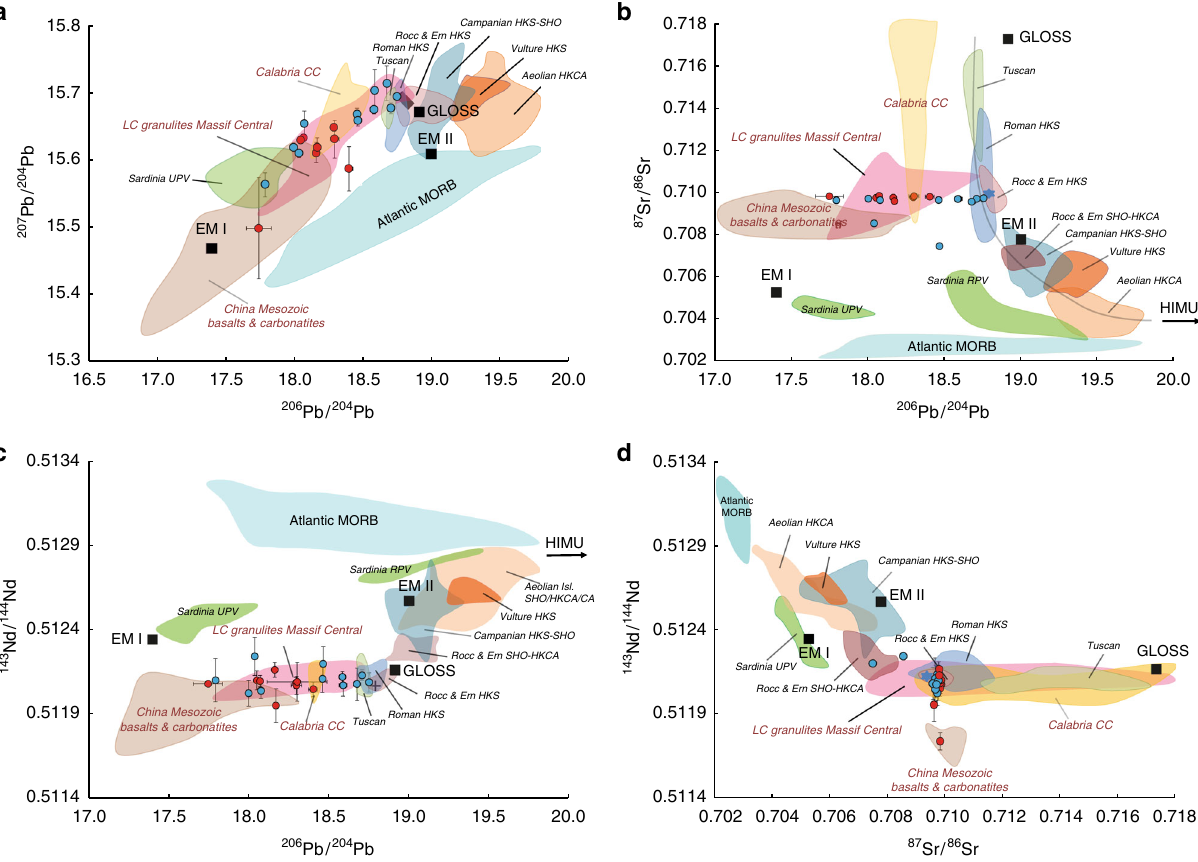
Fig. 3 Sr-Nd-Pb isotope data for the analysed melt inclusions. a 207 Pb/ 204 Pb versus 206 Pb/ 204 Pb; b 87 Sr/ 86 Sr versus 206 Pb/ 204 Pb; c 143 Nd/ 144 Nd versus 206 Pb/ 204 Pb; d 143 Nd/ 144 Nd versus 87 Sr/ 86 Sr. Error bars represent 2SE. Data are compared to fi elds for Italian lavas 76,77 , Calabrian Continental Crust 78 , Atlantic MORB 79 , Massif Central Lower Crustal granulites 80,81 , Mesozoic Chinese basalts and carbonatites 49,82,83 , EM-1 and EMII 84 , and GLOSS 33 . MI source data are provided as a Source Data fi